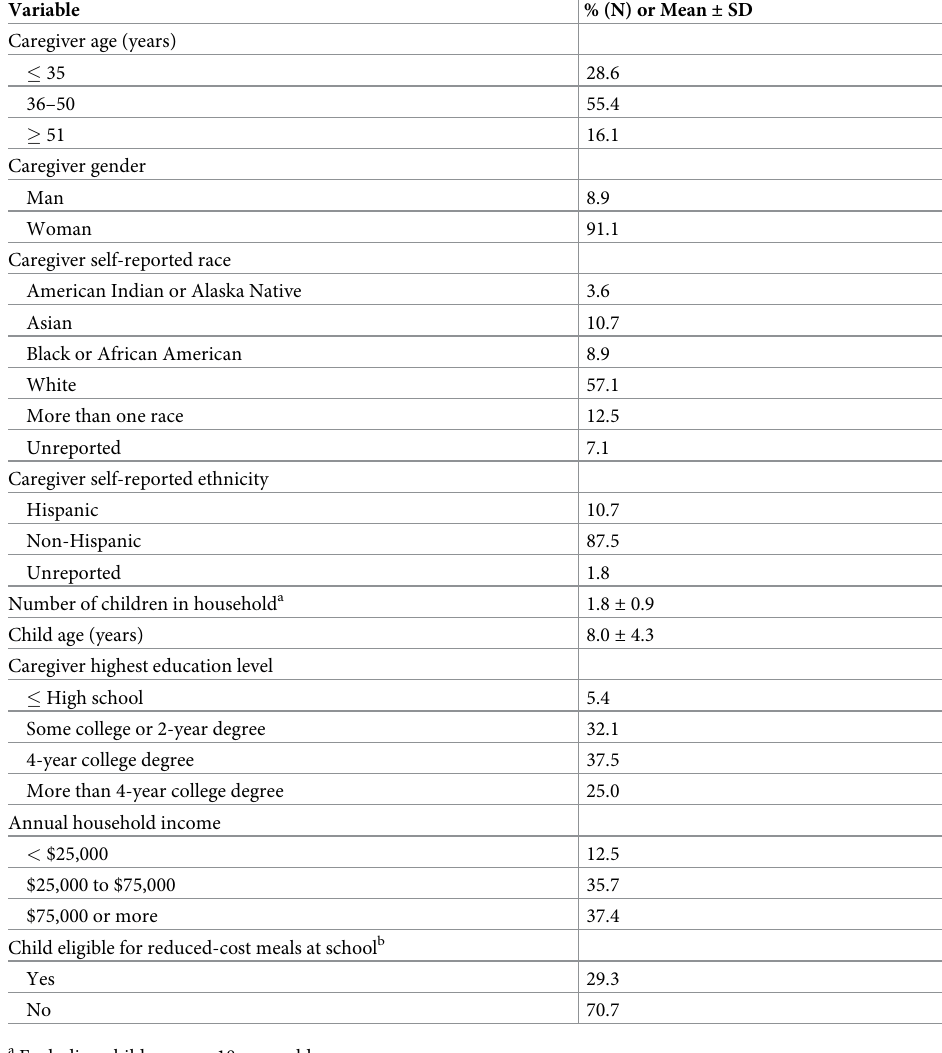
Table 1. Demographic characteristics of caregivers reporting topical fluoride hesitancy for their child or children (N =